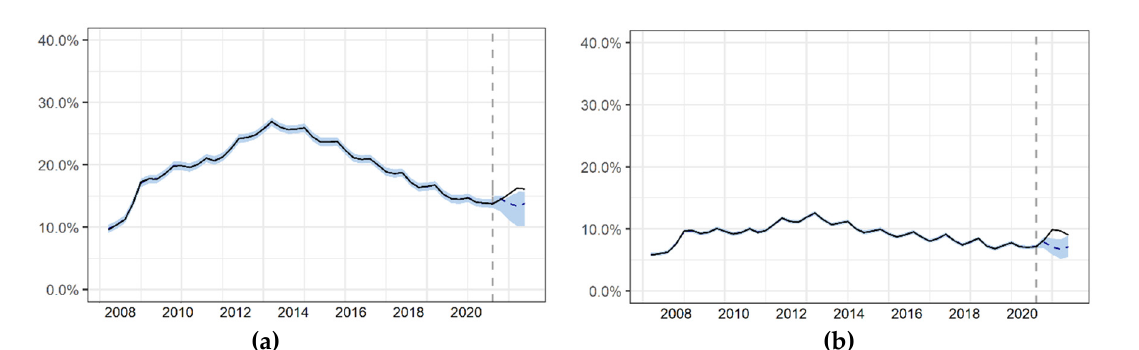
Figure 4. Impact of the COVID-19 crisis on the employment market in Spain. ( a ) Total unemployment rate ( b ) Services sector unemployment rate. Frequency: Quarterly. Table 3. Bayesian structural time series model results for the employment market: relative cumulative effect and 95% Bayesian credible interval.